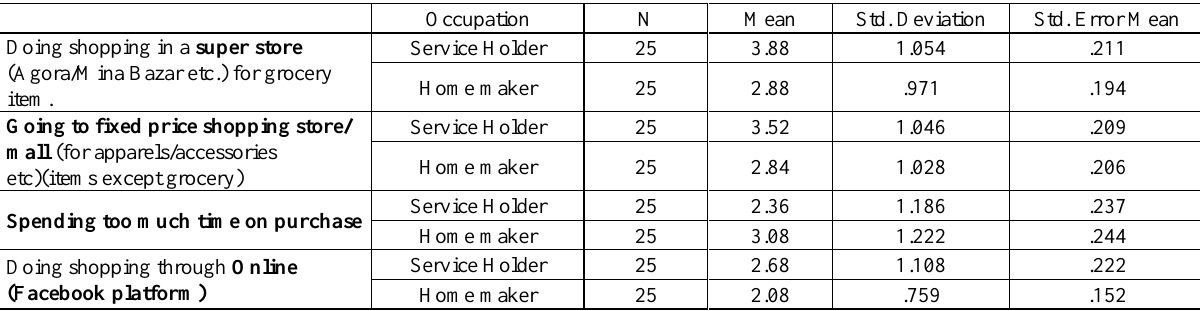
Table 2. Group Statistics of the variables (Superstore, Fixed price mall, Convenience products, Time spend, Online shopping) Occupation N Mean Std. Deviation Std. Error